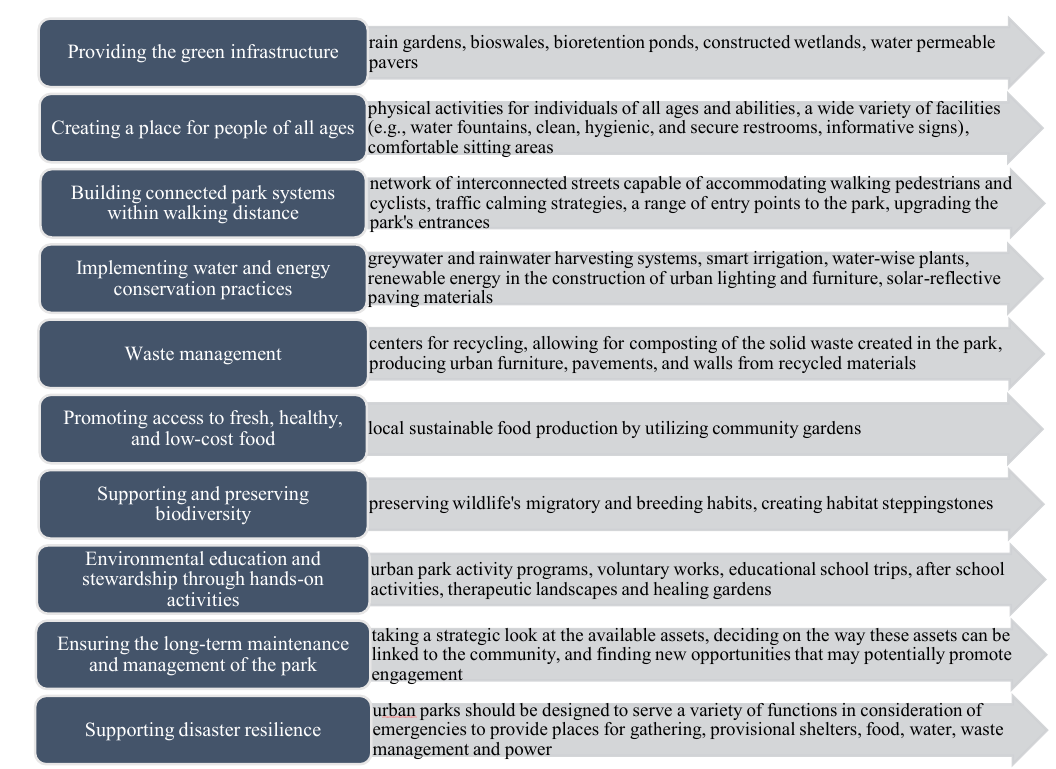
Figure 2. Ten Core Sustainable Design Objectives of Urban